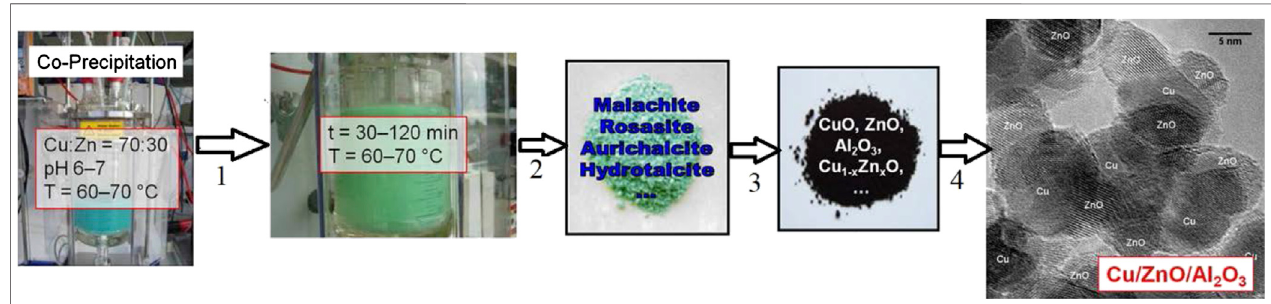
FIGURE 6 | Major steps in co-precipitation synthesis of Cu – ZnO – Al 2 O 3 catalyst developed by ICI. Stages 1 – 4 refer to aging, washing/drying, calcination and reduction, respectively (Behrens and Schlögl, 2013). Reproduced with permission from John Wiley and Sons.